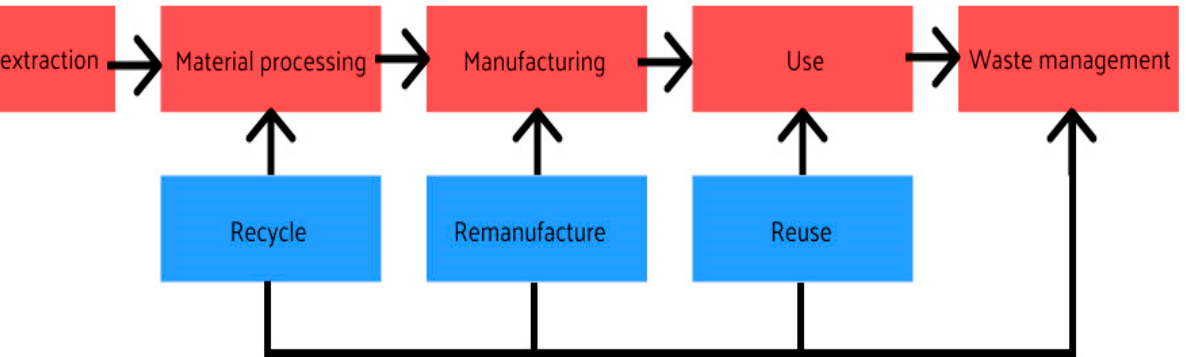
Figure 2. The life cycle of a building viewed as a horizontal process.